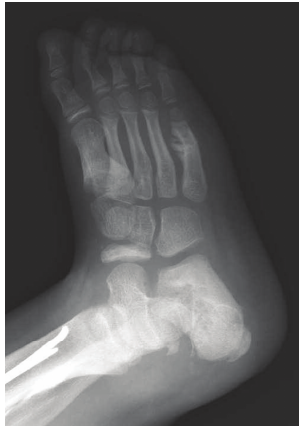
Figure 1: Navicular avascular necrosis and fifth metatarsal fracture in the right foot with hypertrophic bone callus.